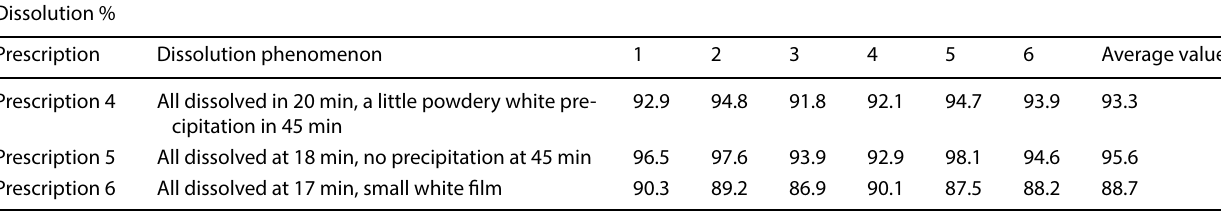
Table 5 Dissolution test results of prescription samples with different isolation layers Dissolution